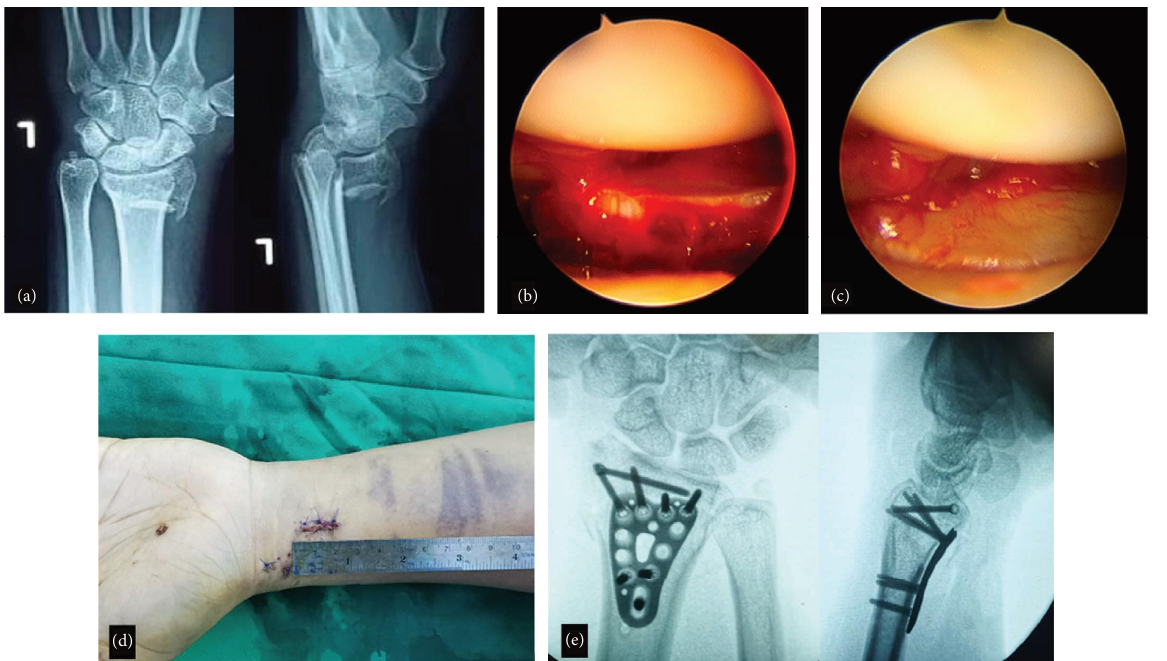
Figure 2: Arthroscopy-assisted intraarticular fracture reduction in Case 2: (a) preoperative X-ray, (b, c) reduction using arthroscopy, (d) closed wound, and (e) fnal result. Table 1: Subjects’ demographic, clinical, and radiographic